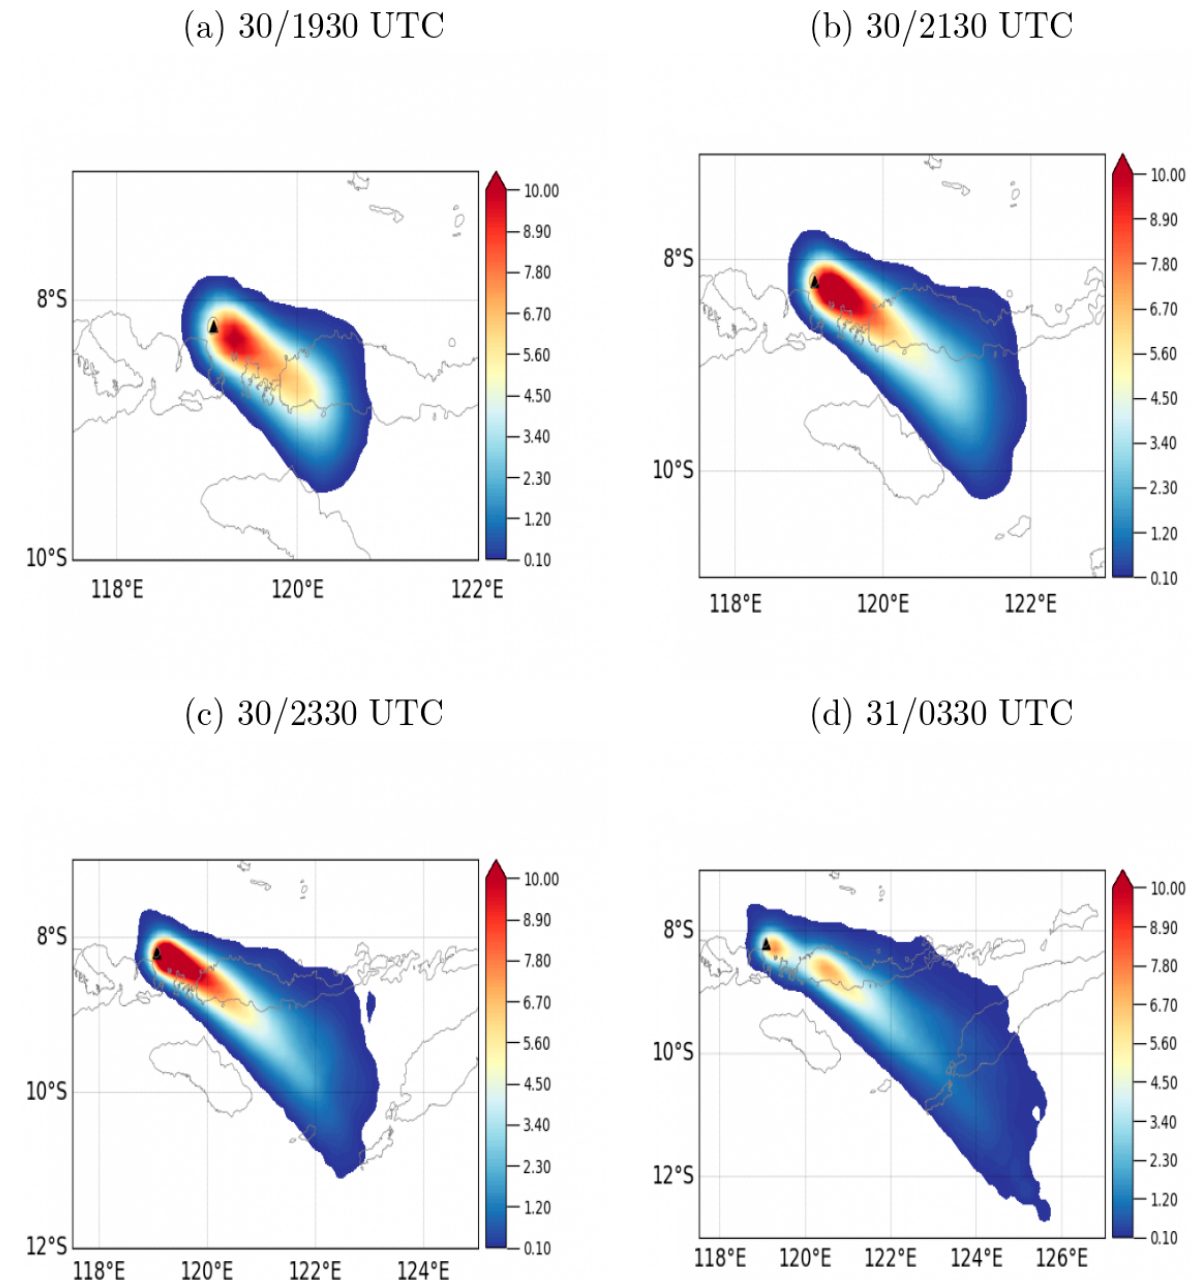
Figure 4. Ensemble mean mass load fields (in g/m 2 ) obtained from the control experiment in this study utilizing a simple top hat function for the source time variation. The black triangle indicates the volcano location.